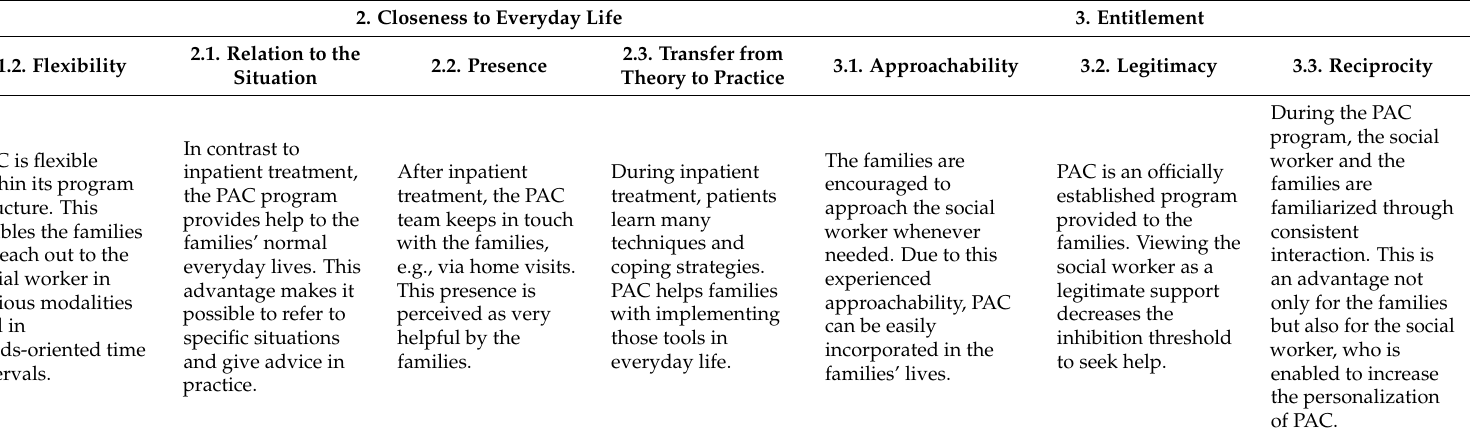
Table 2. Frame conditions of PAC: Subthemes and